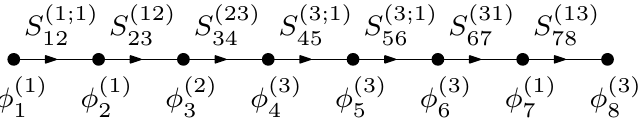
Figure 4. An example of the ordering of free bosons for Y 3 ; 1 ; 4 . The algebra can be found by multiplying the Miura pseudo-di(cid:11)erential operators in the order R (1) as shown in the (cid:12)gure. Alternatively, one can construct the free (cid:12)eld realization as an